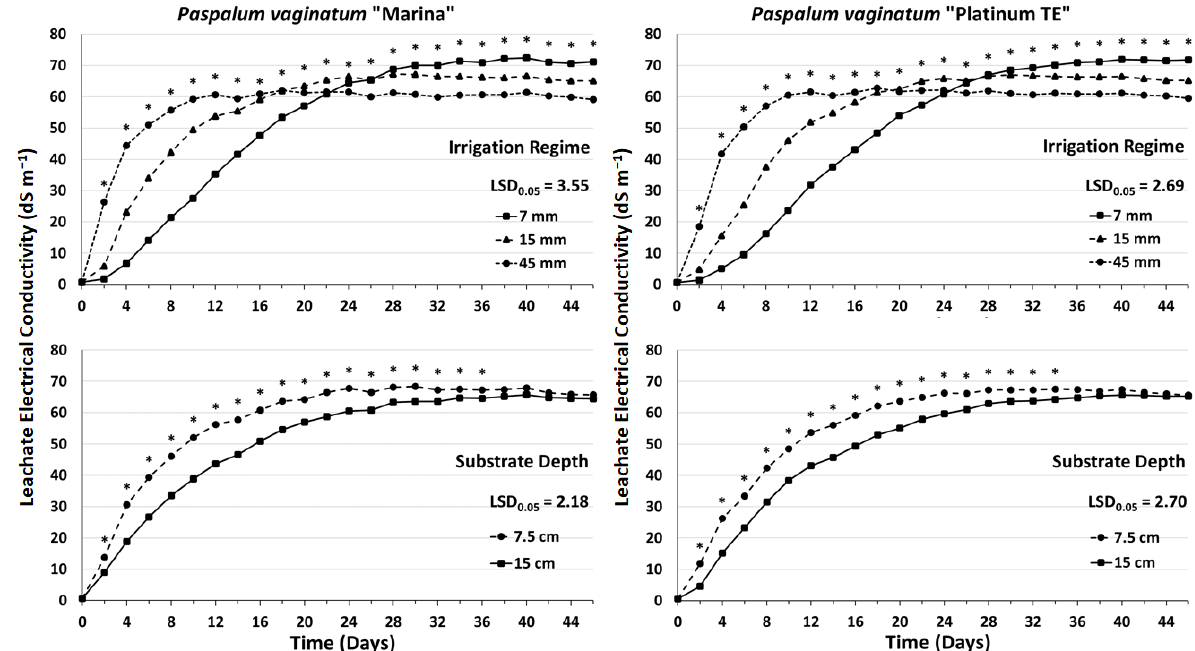
Figure 4. Leachate electrical conductivity (dS m − 1 ) of the two Paspalum vaginatum varieties “Marina” and “Platinum TE”, as affected by seawater irrigation regimes (7 mm, 15 mm, or 45 mm) and green roof substrate depth (7.5 cm or 15 cm) during the salinity stress period (29 July–13 September 2016). Values are the mean of 4 replications. Asterisks (*) indicate significant differences in-between treatment means on a single sampling date, according to Fisher’s least significant difference (LSD) at p < 0.05 following the repeated measures model.